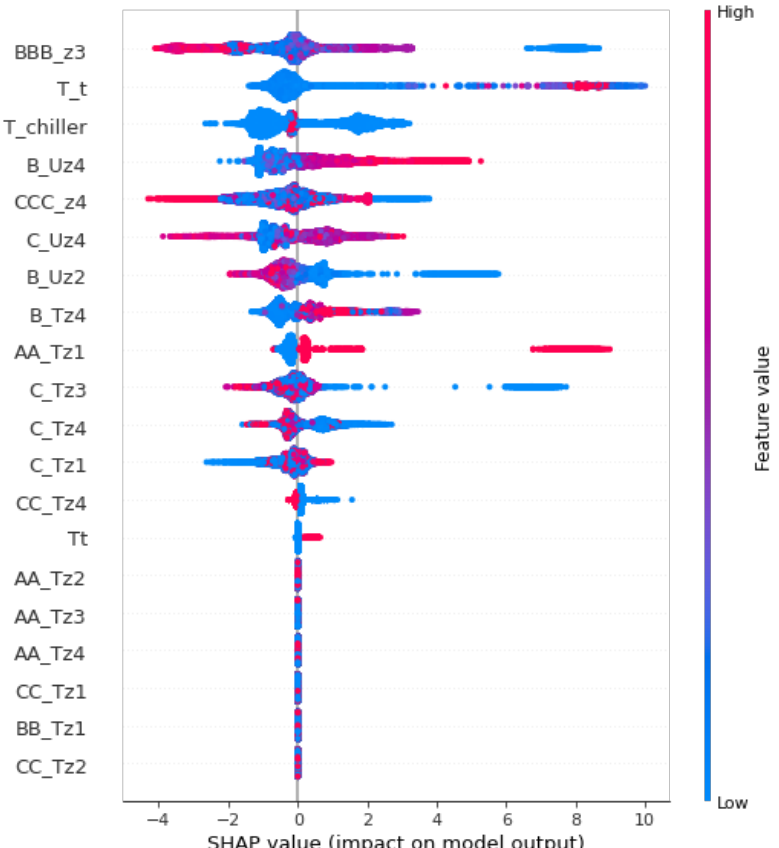
Figure 3. Global Explanation of XGBoost using Figure 3 . Global Explanation of XGBoost using SHAP .